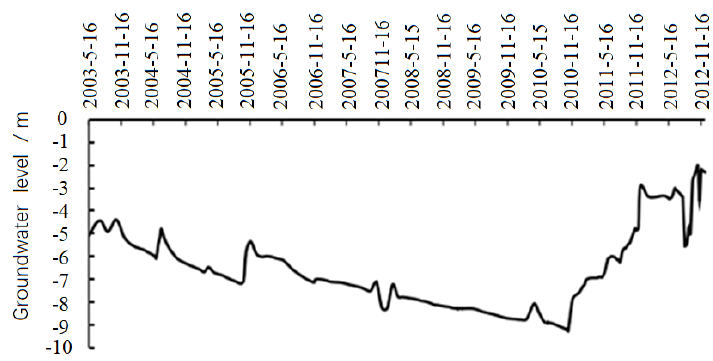
Figure 6. Groundwater level changes of Kogan No. 1 monitoring well.